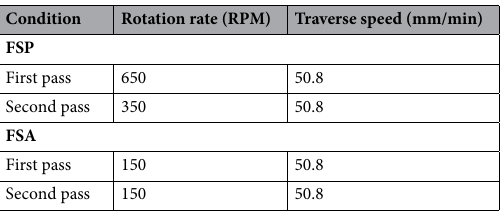
Table 1. Critical process parameters applied for FSP and FSA